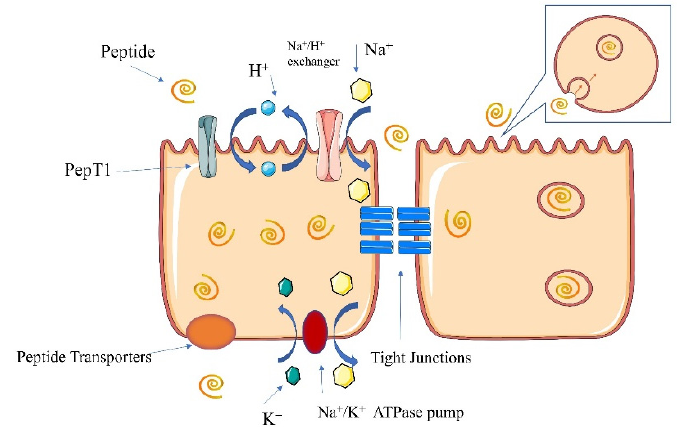
Figure 3. Absorption pathways of peptides in the intestine.